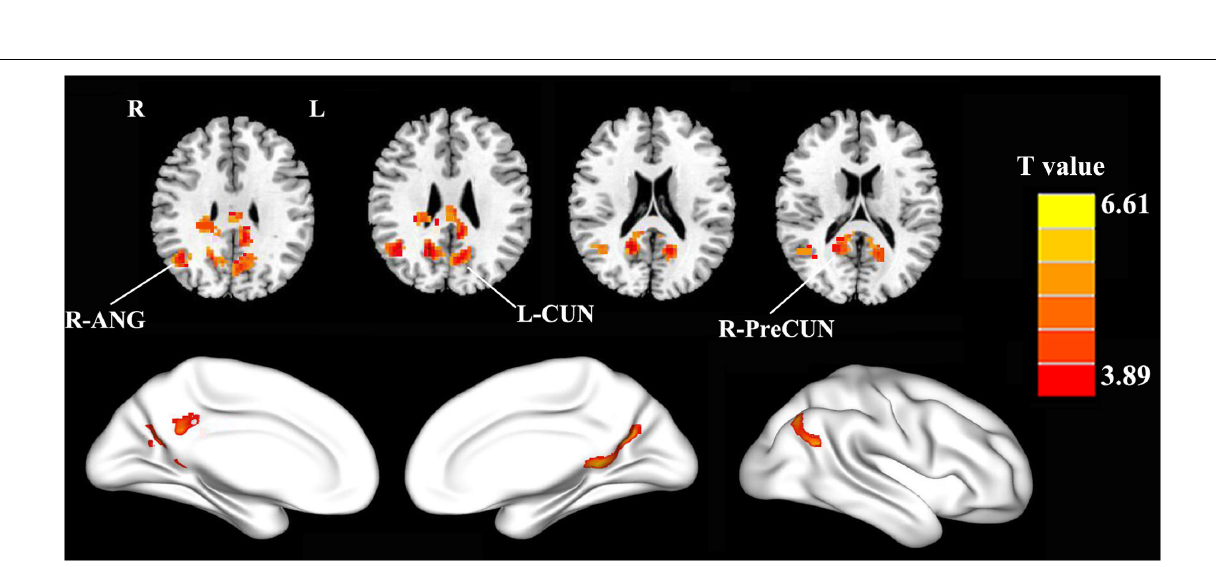
TABLE 2 | Brain region with significant difference in FC values between patients with PD and HCs. Brain regions Peak MNI coordinates Peak t -value Cluster size (number of voxels) X Y BA